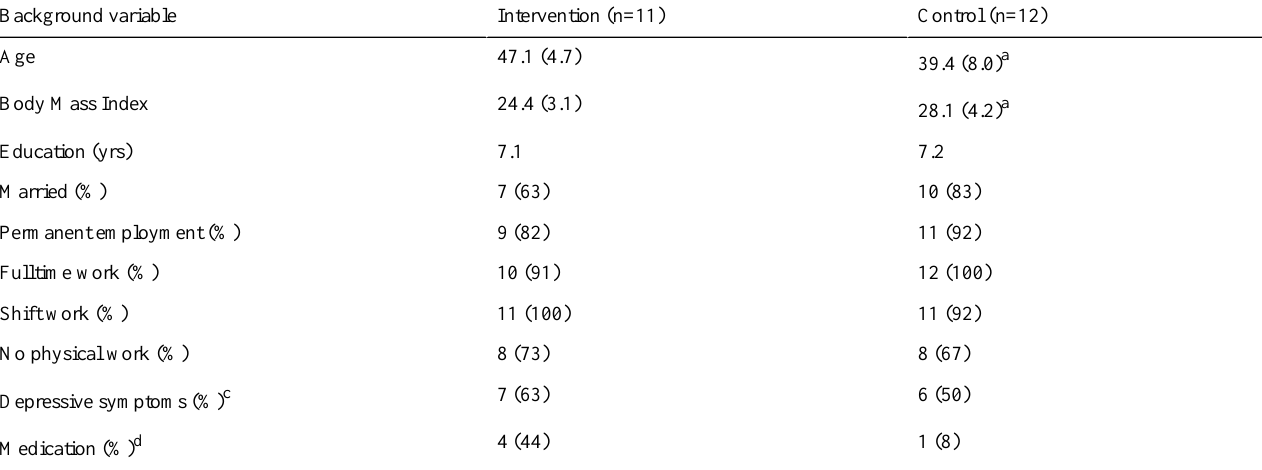
Table 1. Participant